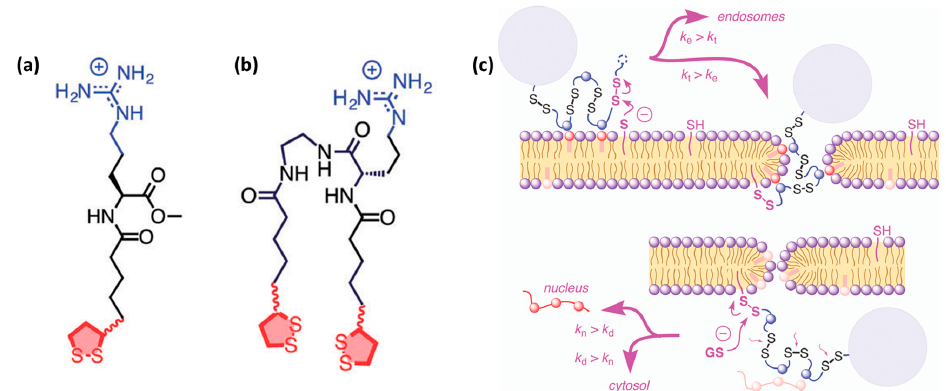
Figure 3. ( a , b ) structures of the most promising examples of cell-penetrating polydisulfides containing guanidinium groups and a polydisulfide backbone, taken in part, with permission from reference [13] (Copyright © 2015, Royal Society of Chemistry). ( c ) Schematic representation of the polydisulfide dynamic covalent chemistry on the cell surface and their cell entry by thiol-mediated uptake, followed by reductive depolymerization by glutathione ( k e = rate of endocytosis, k t = rate of translocation, k d = rate of depolymerization, k n = rate of nuclear uptake), taken from reference [94]. The role of hydrophobicity and aromaticity. In addition to cationic moieties, lipophilic ones are also important for cellular uptake [97–99]. One proposed mechanism implies that hydrophobic counterions form around the guanidinium-rich backbone of CPPs [98]. The counterion effect was first shown as the hydrogen bonding interaction between arginine residues and membrane components, to form complexes that are able to cross membranes [86,100]. This strong bonding of counterions was not observed for lysine-rich peptides, thereby highlighting the relevance of the guanidinium group (Figure 4a,b) [87,100]. The formation of the counterion complexes by the hydrophobic parts of the CPP sequence is referred to as the self-activating property of these peptides [98]. Therefore, studies exploring hydrophobicity, but also individual aliphatic (Figure 4c) and aromatic (Figure 4e) functionality contributions, were needed. Some studies on CPP mimics confirmed that aromatic activators outperform aliphatic ones [97,101].